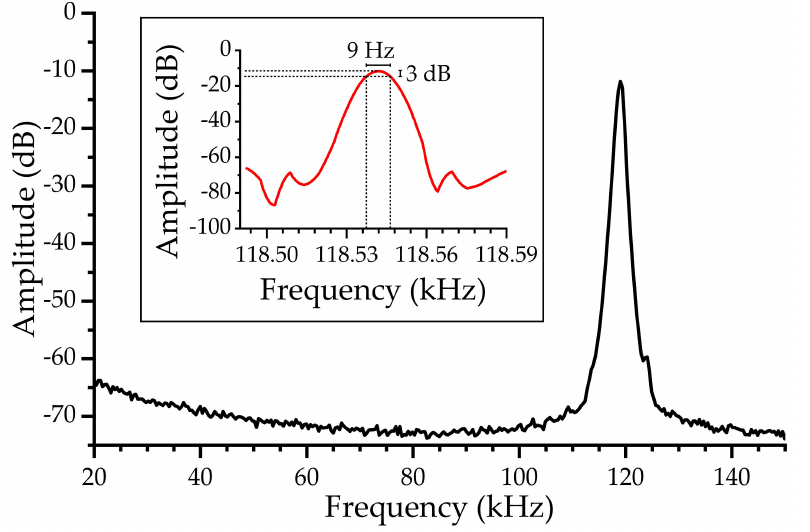
Figure 7. High-resolution frequency spectra for the quality factor determination with 13 Hz steps (black line) and 0.2 Hz steps (red line).